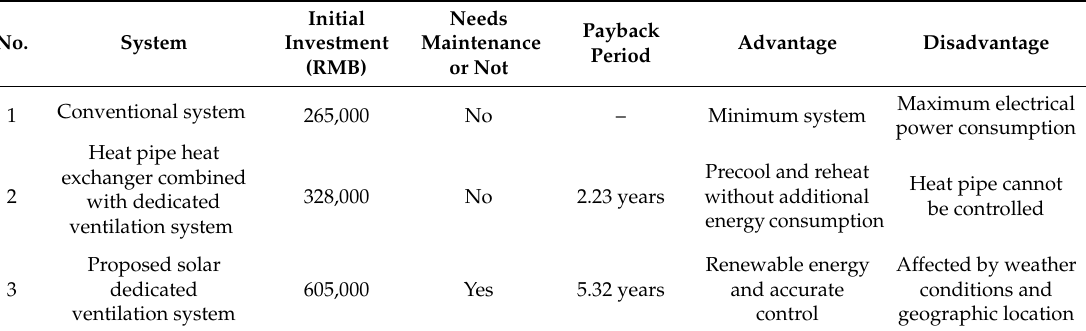
Table 4. Comparison between three different